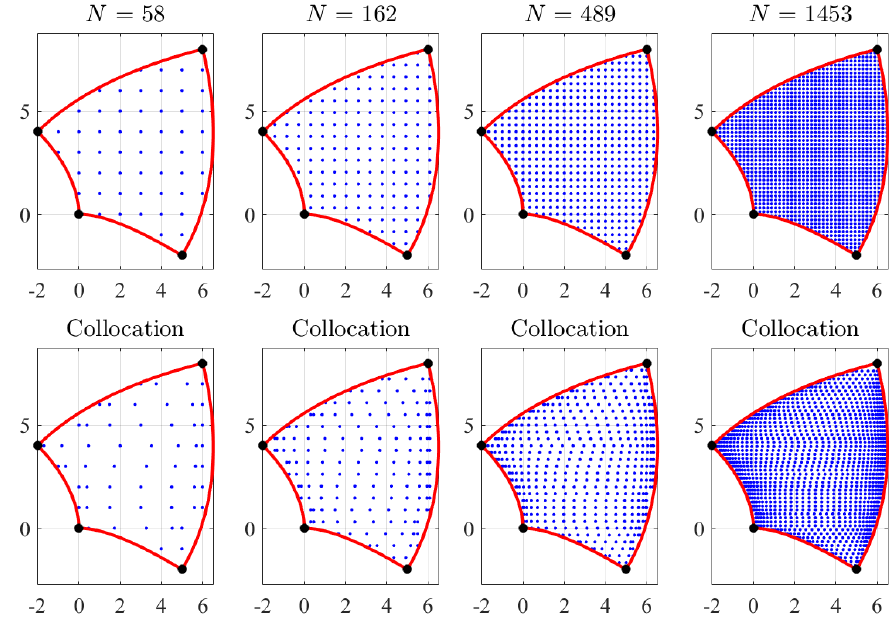
Figure 11. Points selection examples in the W domain: grid ( top ) and collocation ( bottom